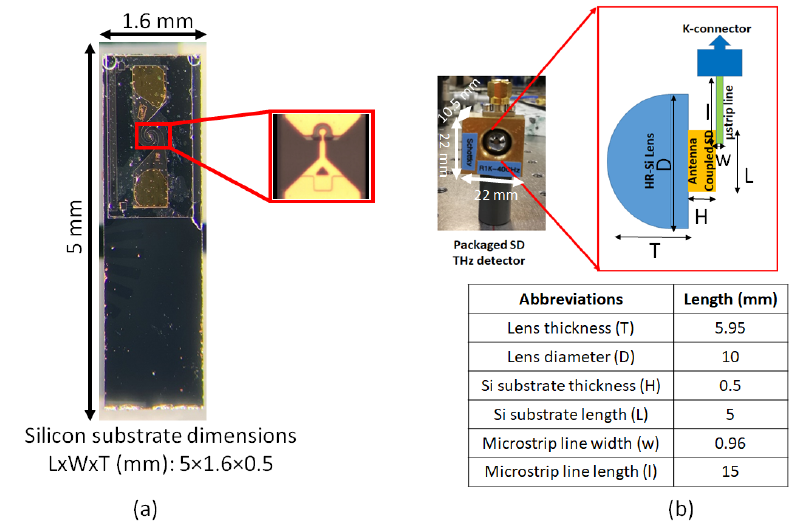
Figure 1. ( a ) Antenna-coupled zero-bias Schottky diode mounted on silicon substrate, inset shows the diode and ( b ) packaged detector in the brass housing. The inset depicts optical and electrical connections of the detectors. Dimensions of the structures are shown in the table.